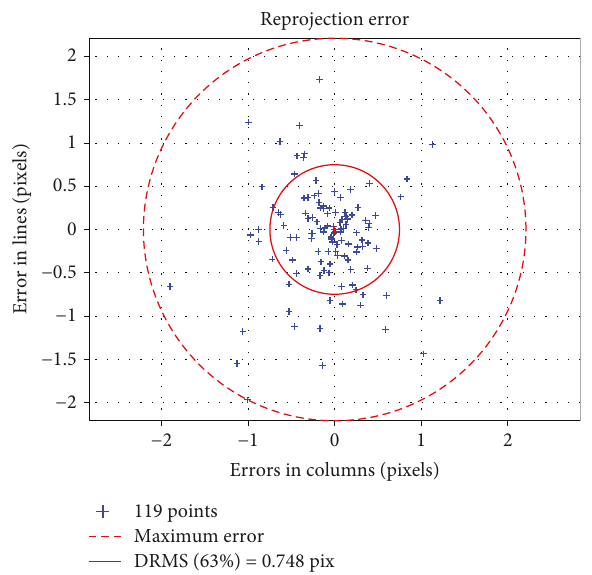
Figure 23: Analysis of the reprojection errors of the markers of the calibration fi eld for the rear camera.